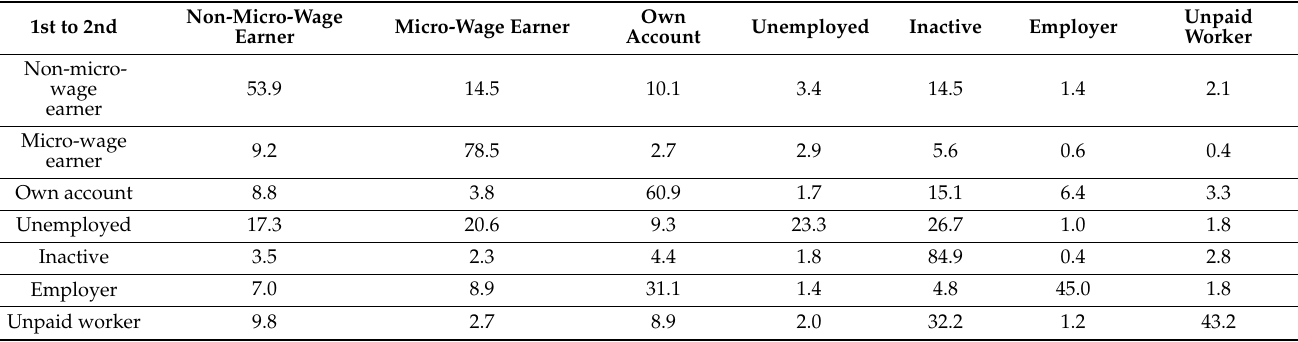
Table 2. Total activity flows for first quarter of 2009